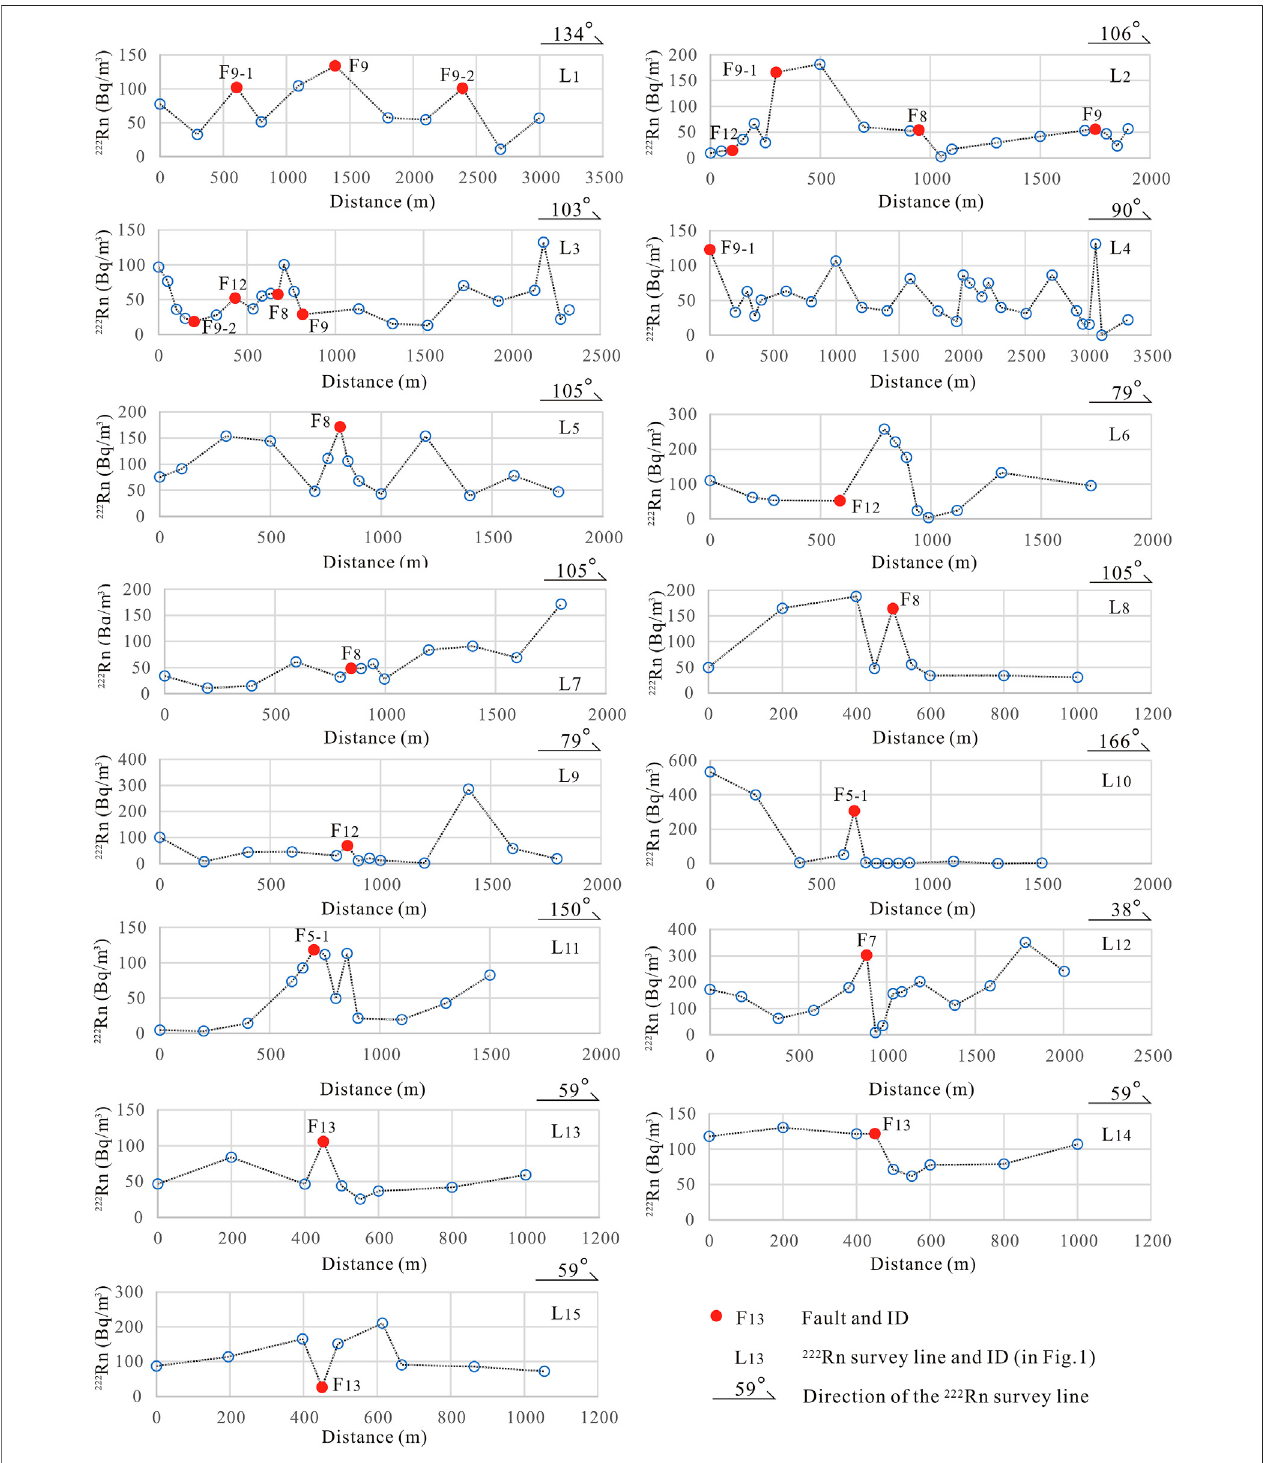
FIGURE 6 | 222 Rn activity in soil gas across main fault segments.